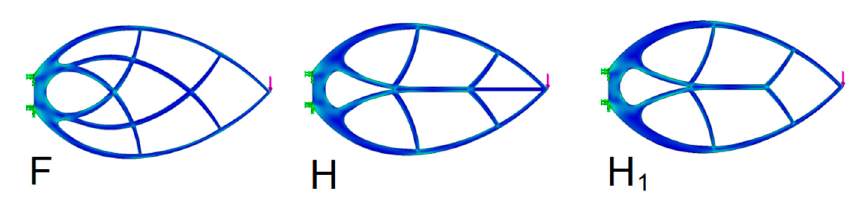
Figure 17. Michell truss F and the orthogonal leaf truss H. Table 5. Comparison of the influence of the combination of the beam C and the Michell truss F.